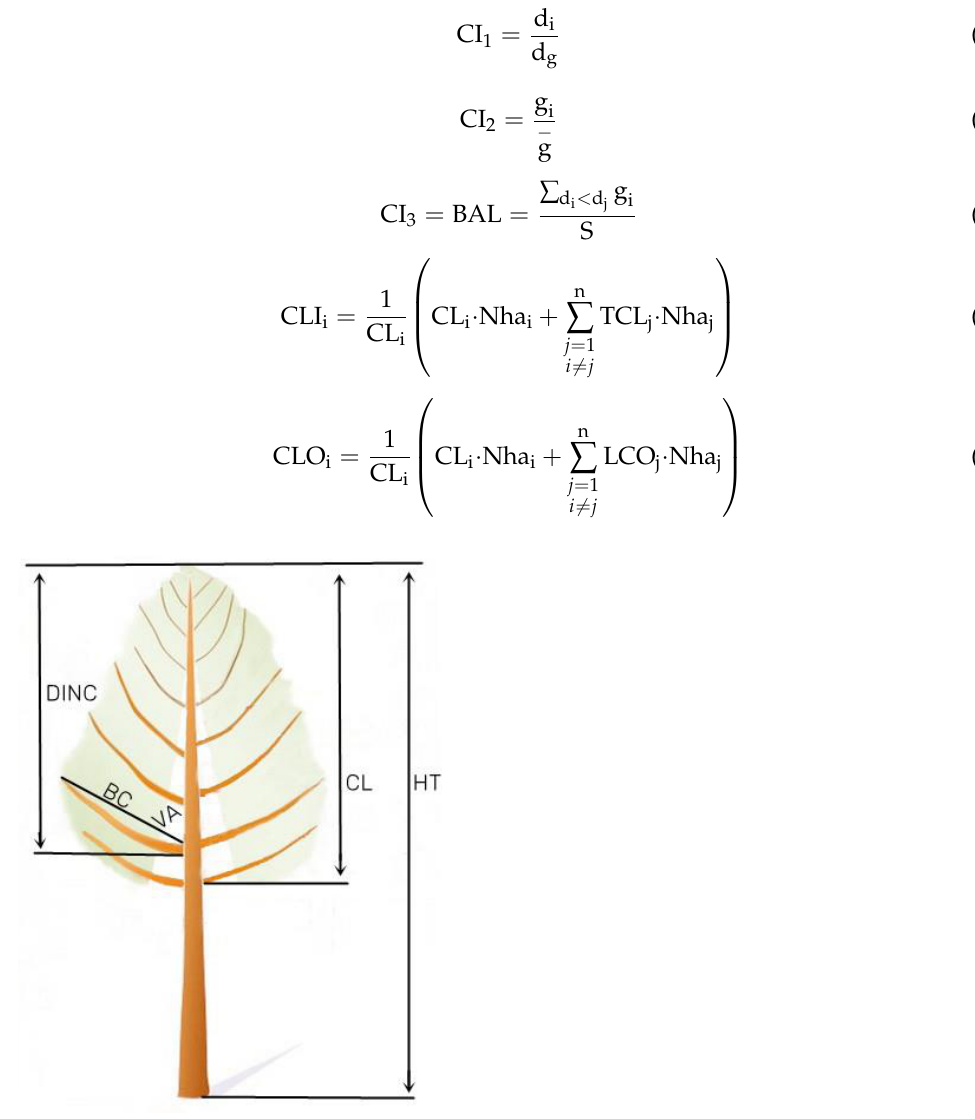
Figure 1. A graphical description for the characteristics of the individual tree and branch variables, which are similar to those in the study of Gao et al. (2021) [8]. HT is total tree height, CL is crown length, DINC is the depth into the crown base from tree tip, BC is branch chord length, and VA is branch angle.